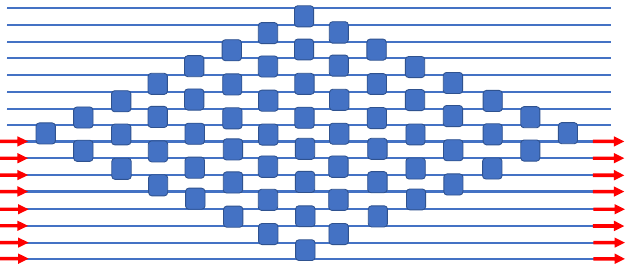
Figure 5. Block diagram of the monochromatic 8 × 8 crosspoint matrix switch. Each blue square indicates an electrically tunable resonant add–drop IDC.